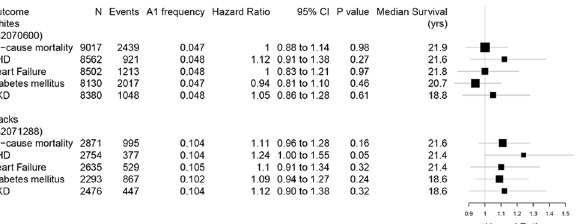
Fig 5. AGER SNPs and risk of death, incident coronary heart disease, heart failure, diabetes, and chronic kidney disease by race. Abbreviations: CHD, coronary heart disease; CKD, chronic kidney disease. Hazard ratio for T vs. C allele adjusted for age, sex, and center. Median follow up in years